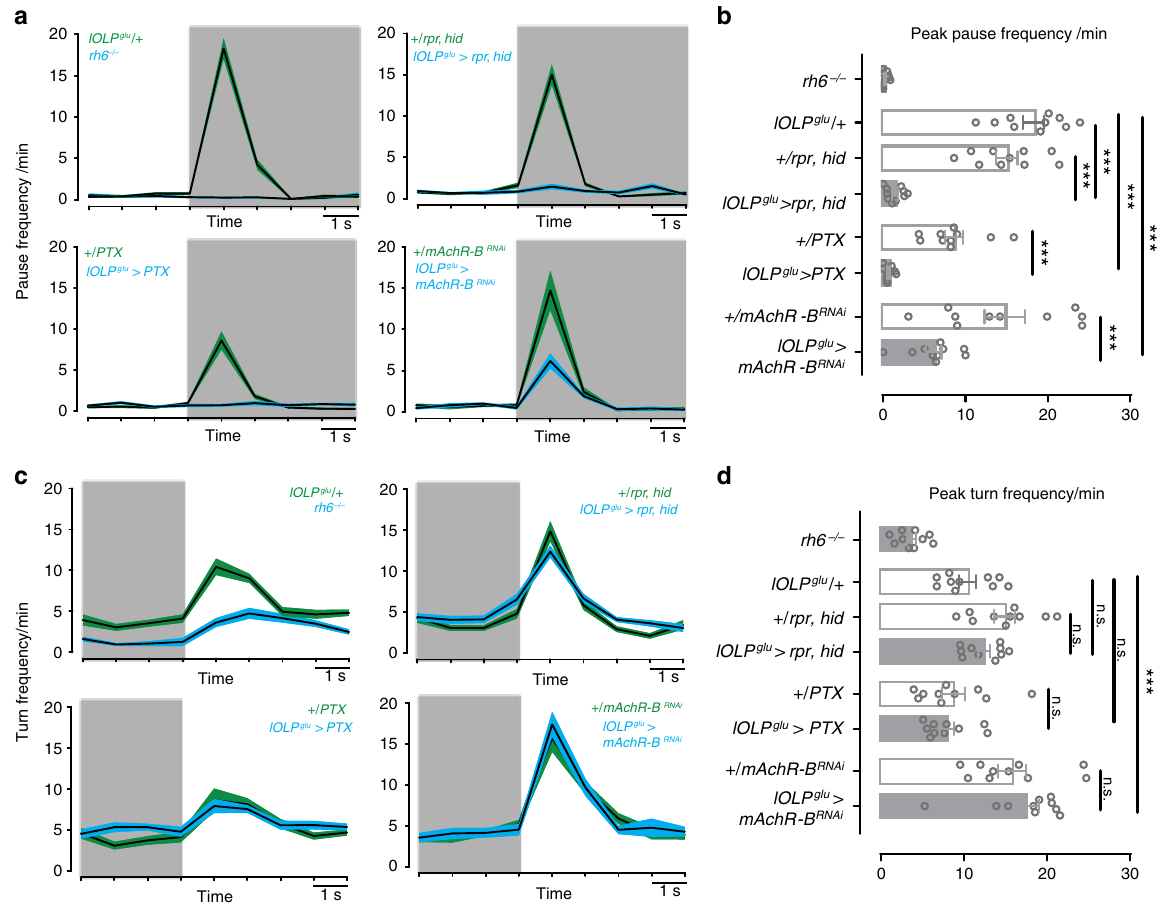
Fig. 8 Glu-lOLP is required for dark-induced pausing behavior. a , b Genetic manipulations of glu-lOLP affect dark-induced pausing behavior in larvae. a Plots of average pause frequency are shown. The transition from light to dark is indicated by the shade of the area. b Quanti fi cation of dark-induced pause frequency reveals the critical role of Rh6-PRs and glu-lOLP in this behavioral response. Statistical signi fi cance determined by one-way ANOVA: p < 2e − 16, F = 35.6, df = 7, 72 followed by post hoc Dunnetts ’ s multiple comparison ’ s test: lOLP glu / + -lOLP glu > rpr, hid: p < 1e − 04, t = 9.907; + /rpr,hid-lOLP glu > rpr, hid: p < 1e − 04, t = 7.990; lOLP glu / + - lOLP glu > PTX: p < 1e − 04, t = 10.337; + /PTX-lOLP glu > PTX: p = 0.000108, t = 4.648; lOLP glu / + -lOLP glu > mAChR-B RNAi : p < 1e − 04, t = 7.120; + /mAChR-B RNAi -lOLP glu > mAChR-B RNAi : p < 1e − 04, t = 5.044. *** P < 0.001. n = 10 for each genotype. c , d The light-induced increase in turning frequency is reduced in Rh6 mutants but unaffected by glu-lOLP manipulations. c Plots of average turn frequency are shown. The transition from dark to light is indicated by the shade of the area. d Quanti fi cations of the light-induced turn frequency reveals that glu-lOLP does not in fl uence the behavioral responses induced by the dark to light transition. Statistical signi fi cance determined by one-way ANOVA: p < 7.16e − 12, F = 14.93, df = 7, 72 followed by post hoc Dunnetts ’ s multiple comparison ’ s test: lOLP glu / + -lOLP glu > rpr, hid: p = 0.753, t = − 1.159; + /rpr,hid-lOLP glu > rpr, hid: p = 0.538, t = 1.472; lOLP glu / + -lOLP glu > PTX: p = 0.530, t = 1.483; + /PTX-lOLP glu > PTX: p = 0.996, t = 0.445; lOLP glu / + -lOLP glu > mAChR- B RNAi : p < 0.001, t = − 4.134; + /mAChR-B RNAi -lOLP glu > mAChR-B RNAi : p = 0.849, t = − 0.996. n.s., p > 0.05, *** p < 0.001. n = 10 for each experiments targeting speci fi c visual tasks are needed to elucidate their speci fi c functions.